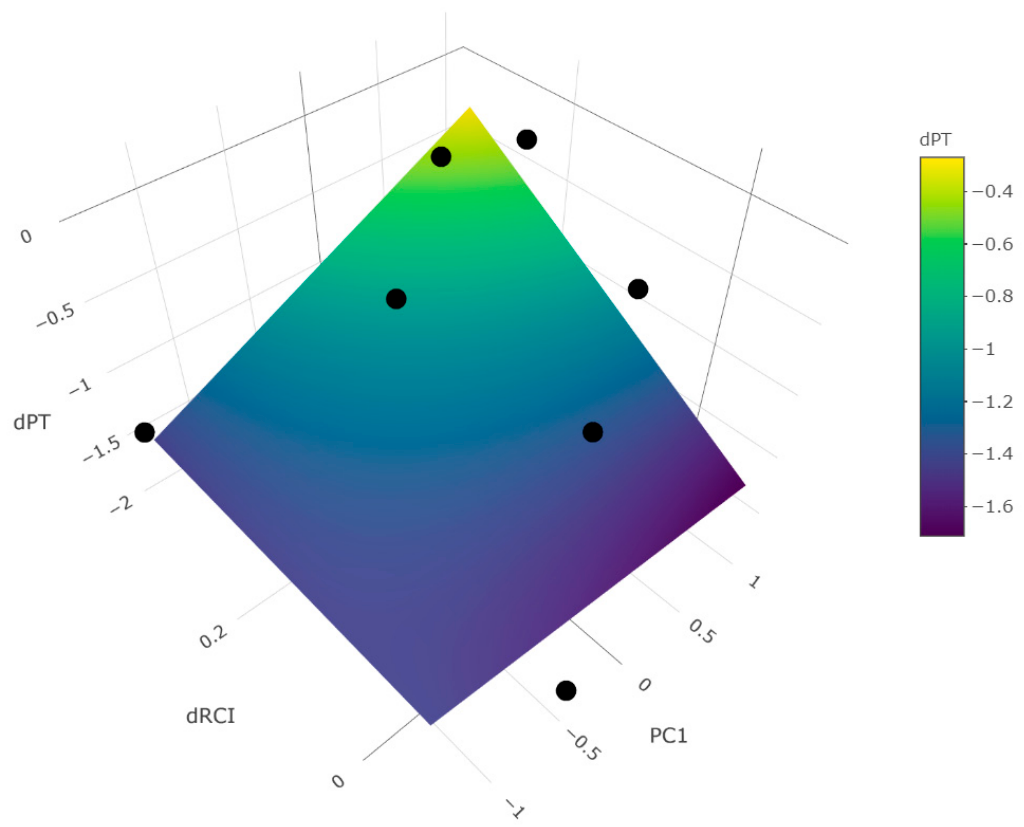
Figure 6. Context dependent change may be common in urban catchments [63], and we found some evidence for environmental contingencies in diatom responses to forest buffers. Increasing urbanization (PC1) weakened the potential for change in riparian habitat ( Δ RCI = dRCI) to influence the reduction in %PT ( Δ PT = dPT). Each point represents a site pair (unbuffered and buffered sites) in the Oslo